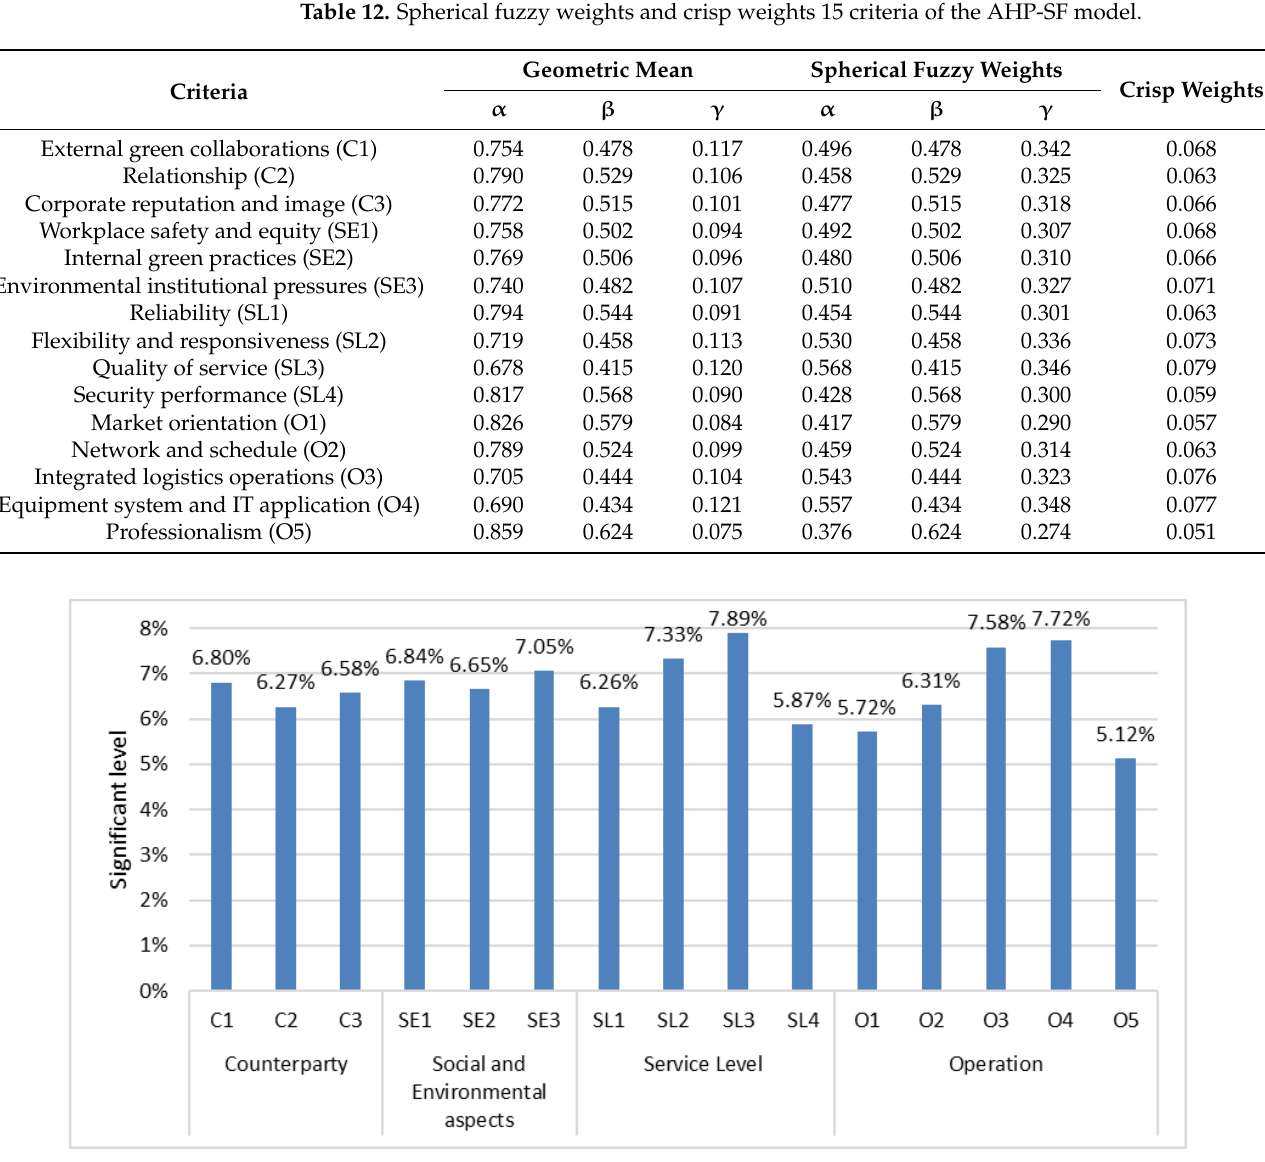
Figure 5. The significant level of 15 criteria of the AHP-SF model.